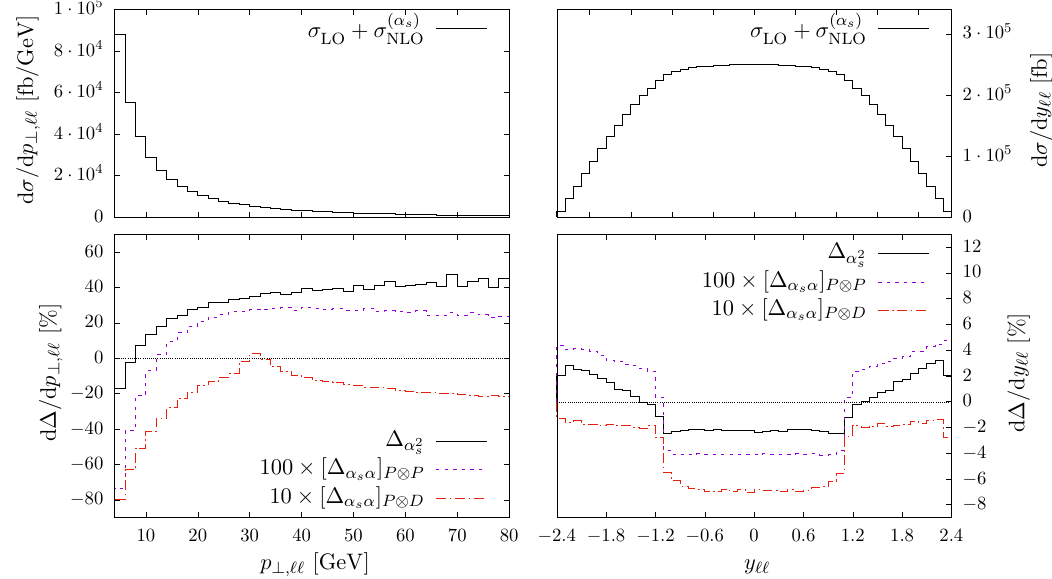
Figure 4. Relative di(cid:11)erential corrections (cid:1) for the transverse momentum (left) and rapidity (right) of the dilepton system, p ? ;‘‘ and y ‘‘ . See text for further details.